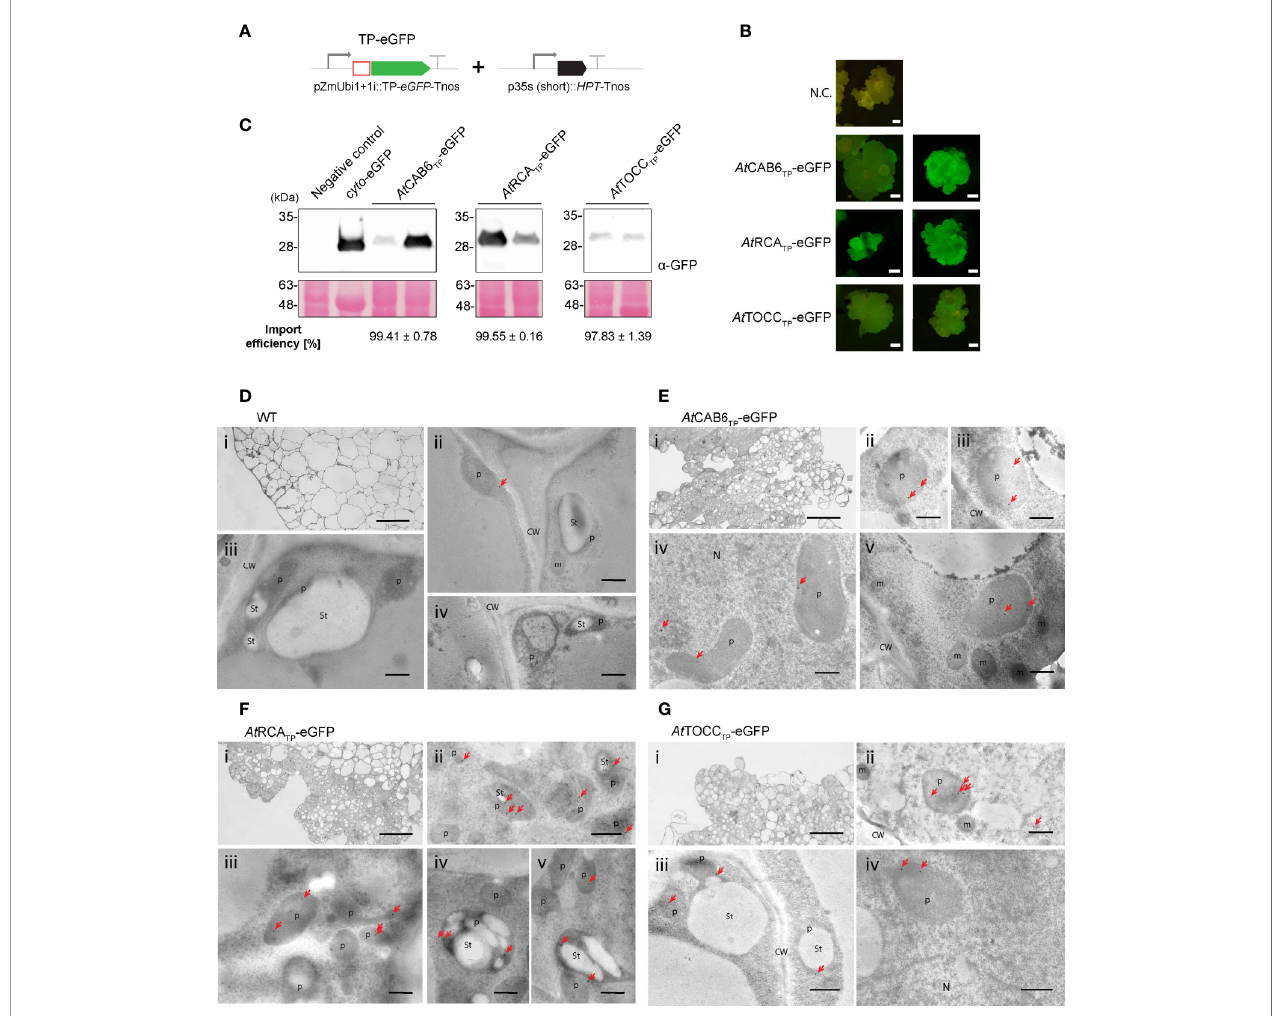
FIGURE 4 | Stably transformed rice callus lines exhibit eGFP targeting into rice pro-plastids by Arabidopsis transit peptides (TPs). (A) Schematic representation of the constructs used for stable transformation of O. sativa , leading to eGFP expression and localization. (B) Stereomicroscope fl uorescence images from two independent transformed callus lines expressing At CAB6 TP -eGFP, At RCA TP -eGFP, or At TOCC TP -eGFP. N.C. corresponds to “ Negative Control ” , a transformed callus line expressing only the HPT resistance cassette. Scale bars = 1 mm. (C) Western blot analysis of callus soluble protein extracts from two independent transformed rice lines with the indicated constructs incubated with anti-GFP antibody. eGFP produced in N. benthamiana was used as a positive size control. Import ef fi ciency was de fi ned as the percentage of the processed faster-migrating protein form relative to the total amount of expressed eGFP protein. Data shown are means ± SD of three independent extractions. (D-G) Immunogold labeling of eGFP in proplastids of rice callus cells using a GFP-speci fi c monoclonal antibody (diluted 1:250). (D) Wild-type cells. (E) At CAB6 TP -eGFP. (F) At RCA TP -eGFP. (G) At TOCC TP -eGFP. i: Light microscopy (LM) image of studied section; ii-v: Transmission electron microscope (TEM) images. (CW, cell wall; m, mitochondria; N, nucleus; p, plastid like; St, starch; bars i = 50 µm, ii – v = 500 nm; gold particle size = 15